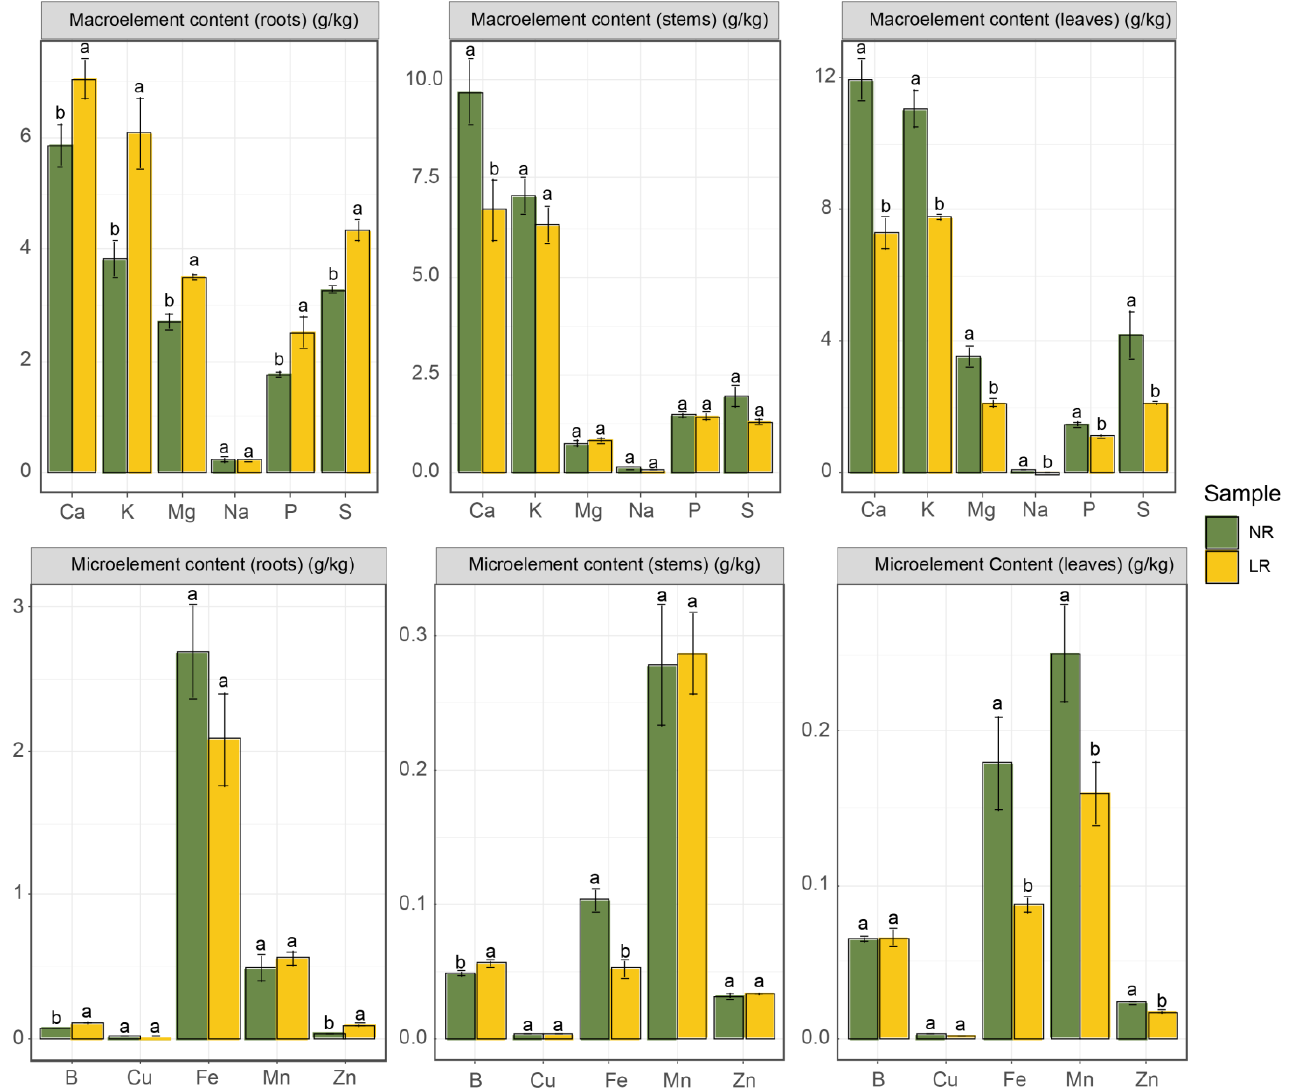
Figure 2. Elemental content in roots, stems and leaves of highbush blueberry plants with normal or limited growth. NR-normally growing plants; LR-limited-growth plants. For individual elements and tissues, different lower-case letters indicate significant differences ( p ≤0.0 5).